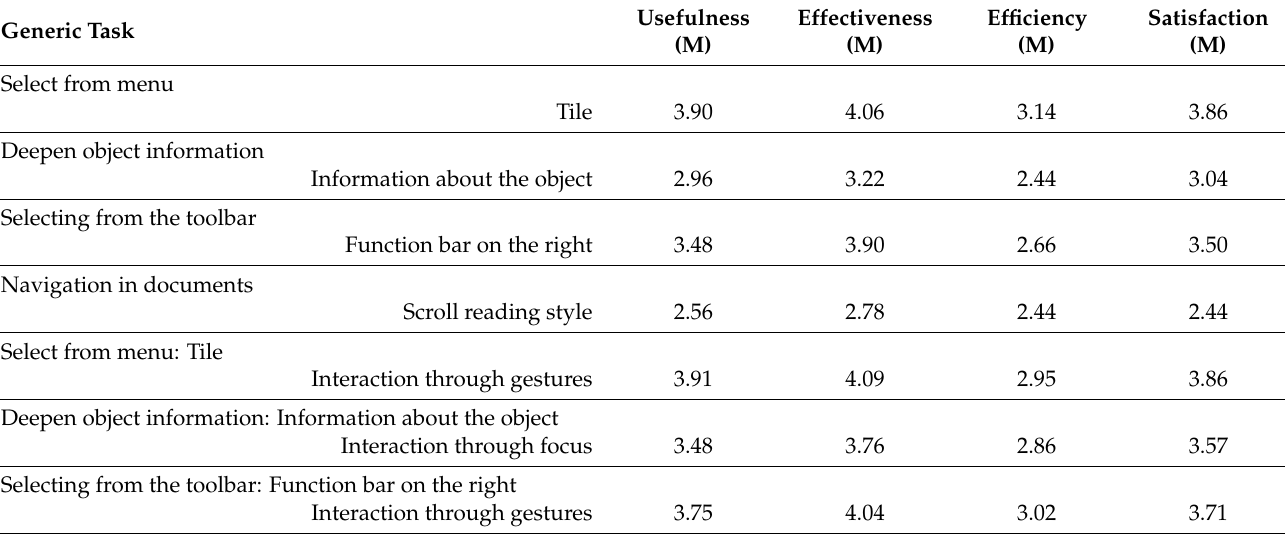
Table 10. Extract from the evaluation of layout